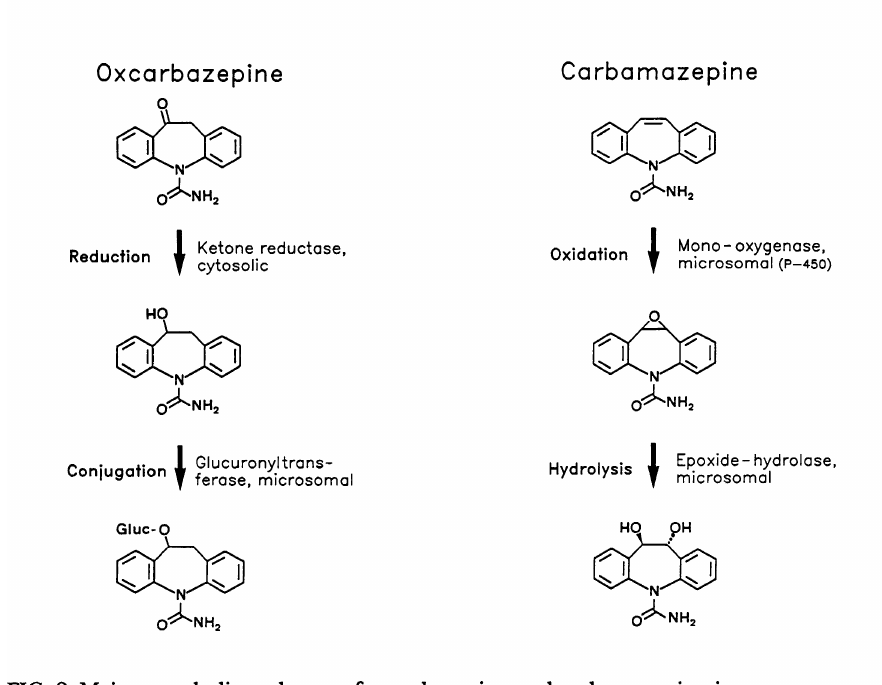
FIG. 2. Major metabolic pathways of oxcarbazepine and carbamazepine in